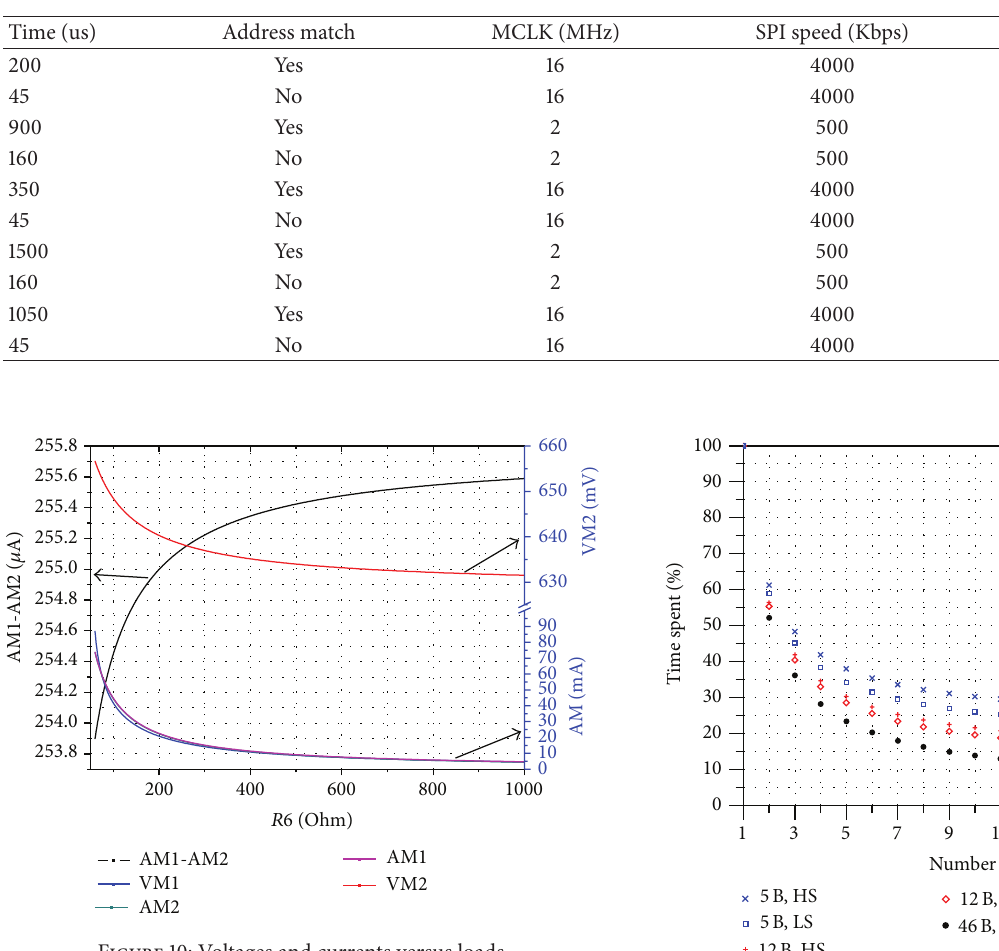
Table 2: Processing times of different packet lengths and hardware.